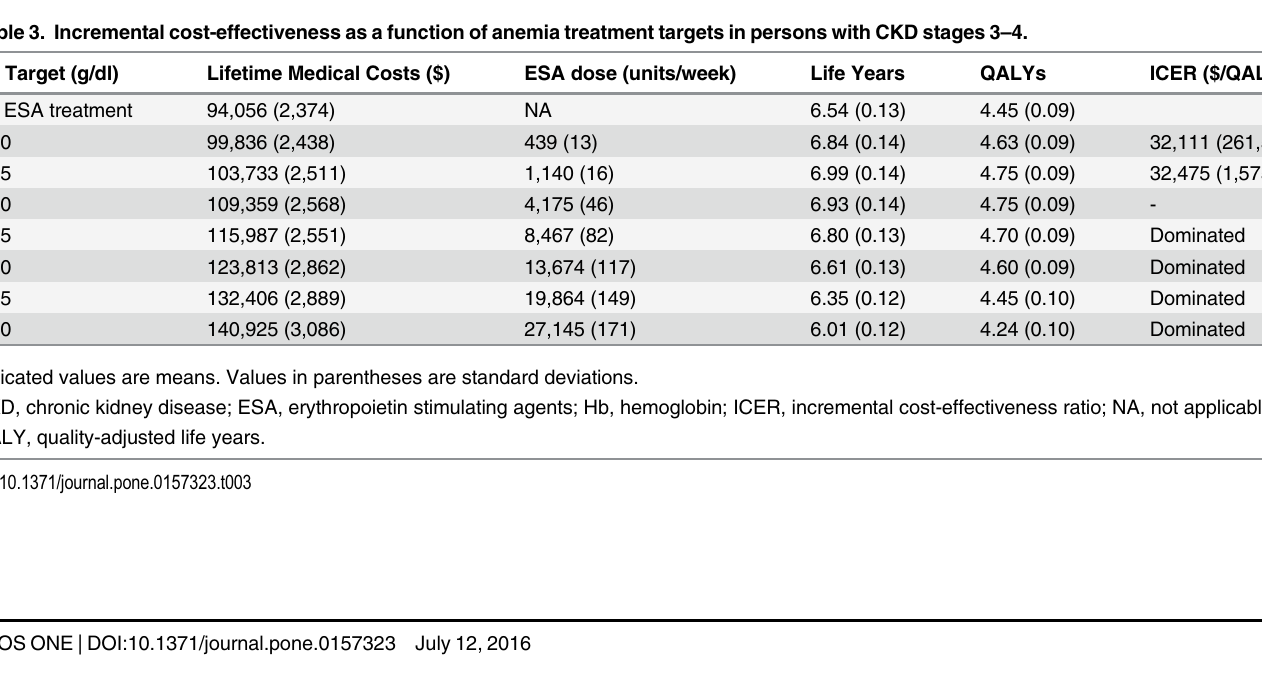
Table 3. Incremental cost-effectiveness as a function of anemia treatment targets in persons with CKD stages 3 – 4. Hb Target (g/dl)